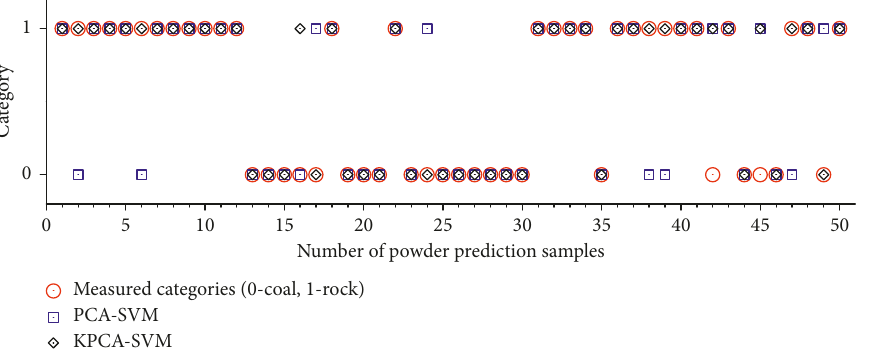
Figure 11: Prediction results of 50 powder prediction samples by PCA-SVM and GRB-KPCA-SVM